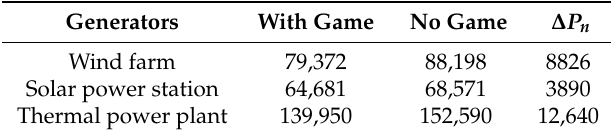
Figure 5. Wheeling cost of generators: ( a ) Wind farms, ( b ) Solar power stations and ( c ) Thermal power plant. Table 1. Daily wheeling cost of each generator (dollars).